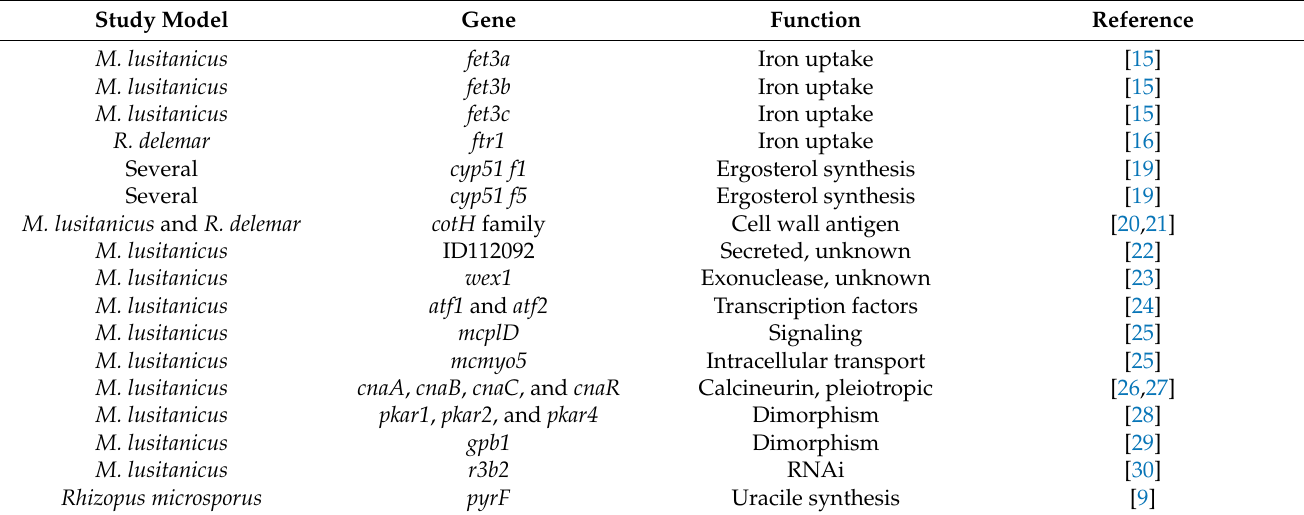
Table 1. Genes recently involved in the virulence potential of Mucorales